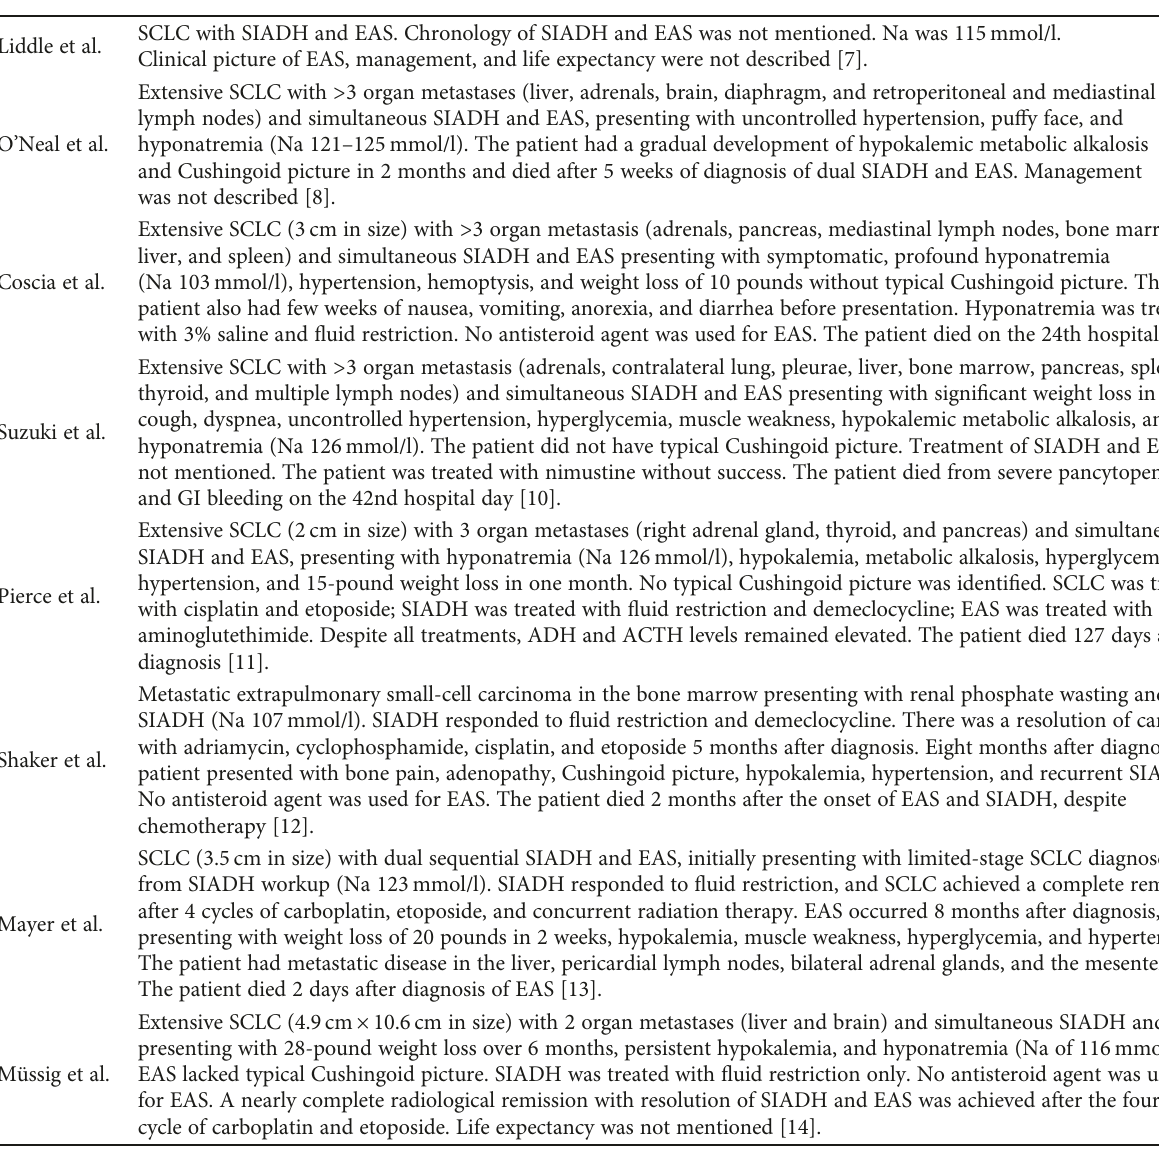
Table 2: Summary of previously published case reports of SCLC with dual ectopic ADH and ACTH secretion. SCLC with SIADH and EAS. Chronology of SIADH and EAS was not mentioned. Na was 115 mmol/l. Liddle et al. Clinical picture of EAS, management, and life expectancy were not described